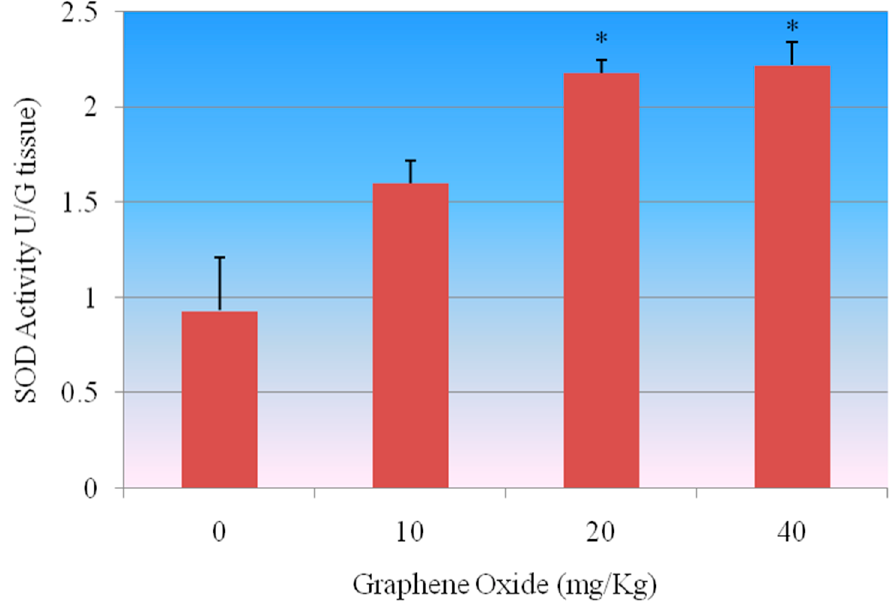
Figure 6. Effect of GOs on SOD activities in kidneys of rats after 5 days. Each bar represents mean ± SD of five rats. Values with asterisks were significantly different from control. Statistical significance ( p < 0.05) is depicted as ( * ).